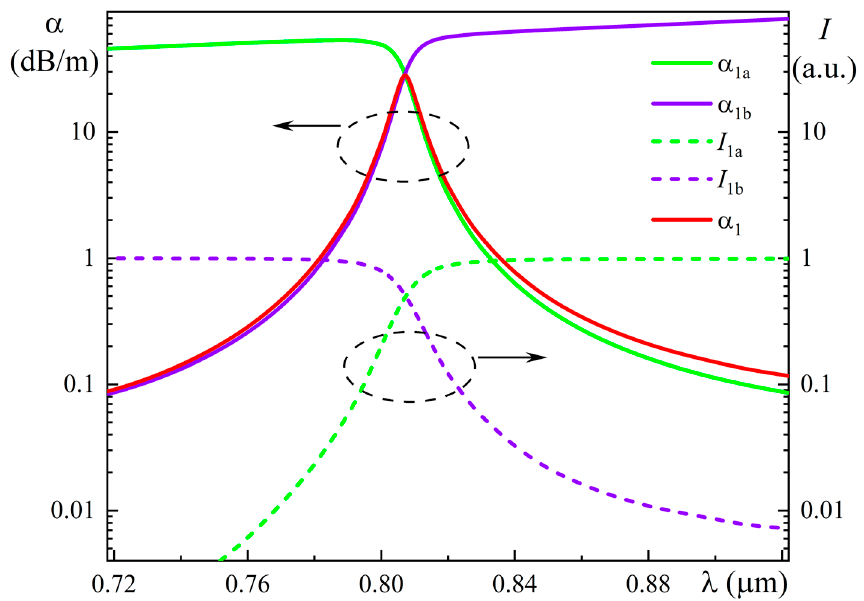
Figure 9. Spectral dependences of the leakage losses ( α 1a and α 1b ) and intensities ( I 1a and I 1b ) of Modes 1a and 1b in the bent MOF-18 for bending radius R x = 0.08 m, and the resulting leakage loss for FM 1 ( α 1 ).